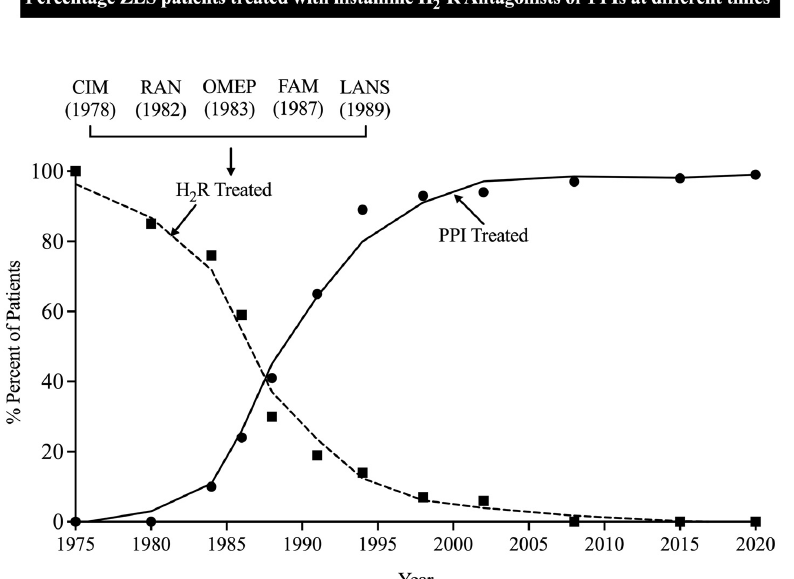
Figure 1. Time course of acid antisecretory drug treatment in 303 patients with ZES. Shown are the percentages of ZES patients with acid hypersecretion during different time periods treated with either histamine H 2 -receptor antagonists (cimetidine, ranitidine, famotidine, nizatidine) or proton pump inhibitors (PPIs) (omeprazole, lansoprazole, pantoprazole). The time periods analyzed were 1/76–1/83 (90 patients), 2/83–1/85 (117 patients), 2/85–1/87 (147 patients), 2/87–1/90 (177 patients), 2/90–1/93 (196 patients), 2/93–1/96 (216 patients), 2/96–1/99 (210 patients), 2/99–1/2002 (188 patients), 2/2002– 1/2006 (166 patients), and 2/2006–2020 (91 patients). Data are reported as percentage of patients